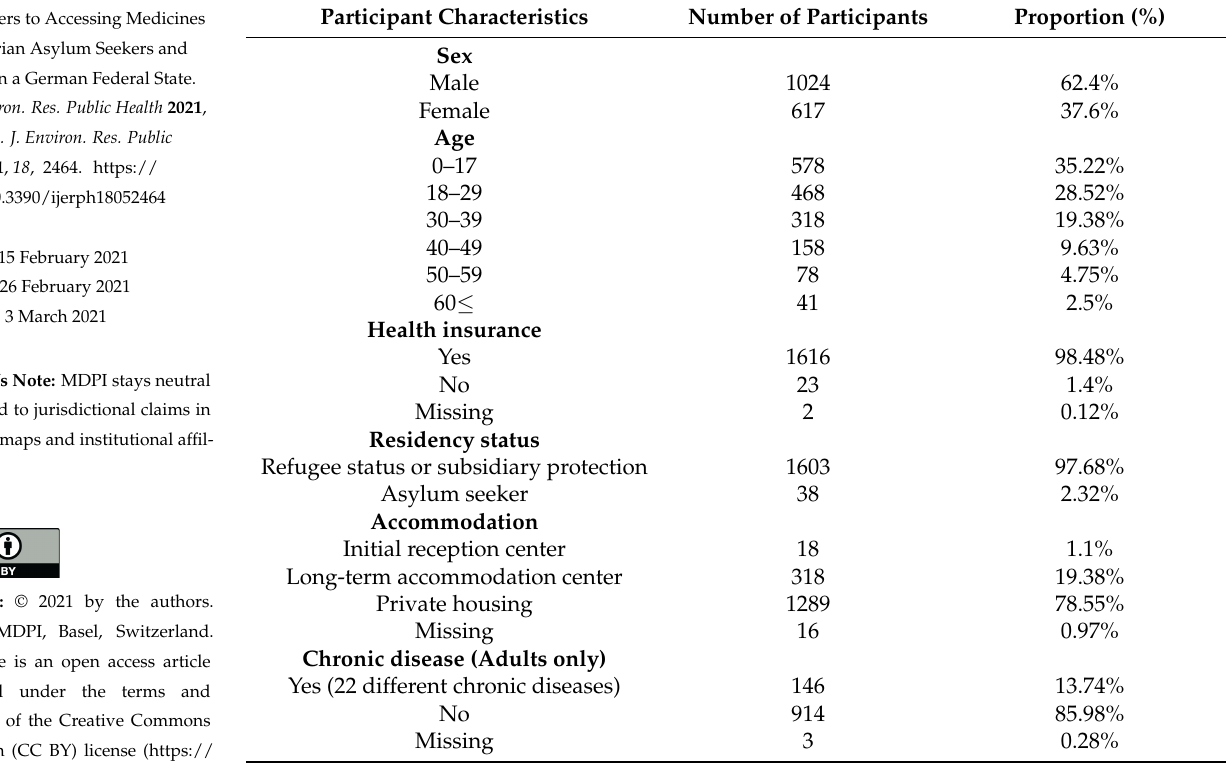
Table 1. Sociodemographic characteristics of the study participants. Participant